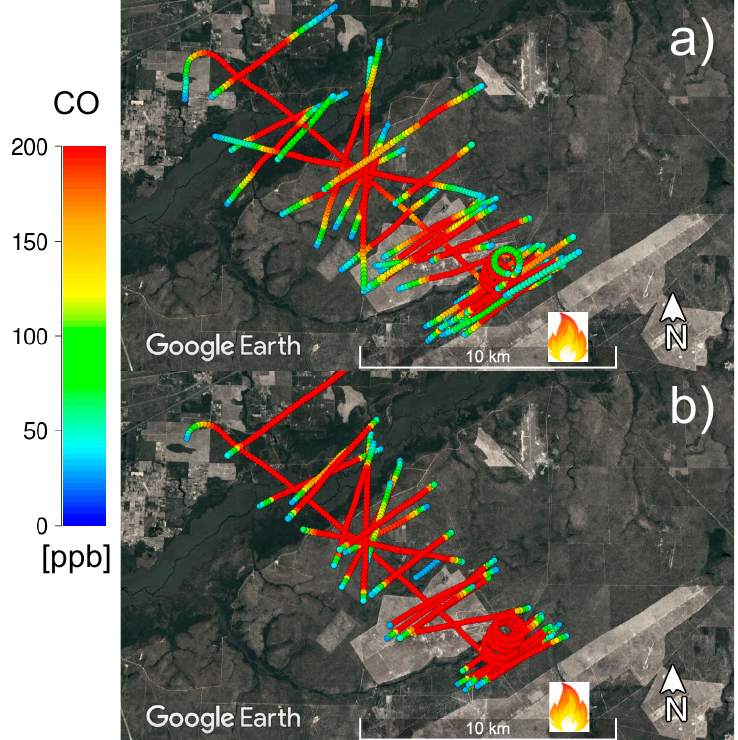
Figure 9. ( a ) Observed and ( b ) modeled smoke enhancements (ICM configuration) during the L2F prescribed burn. All enhancements at near background levels were not plotted.